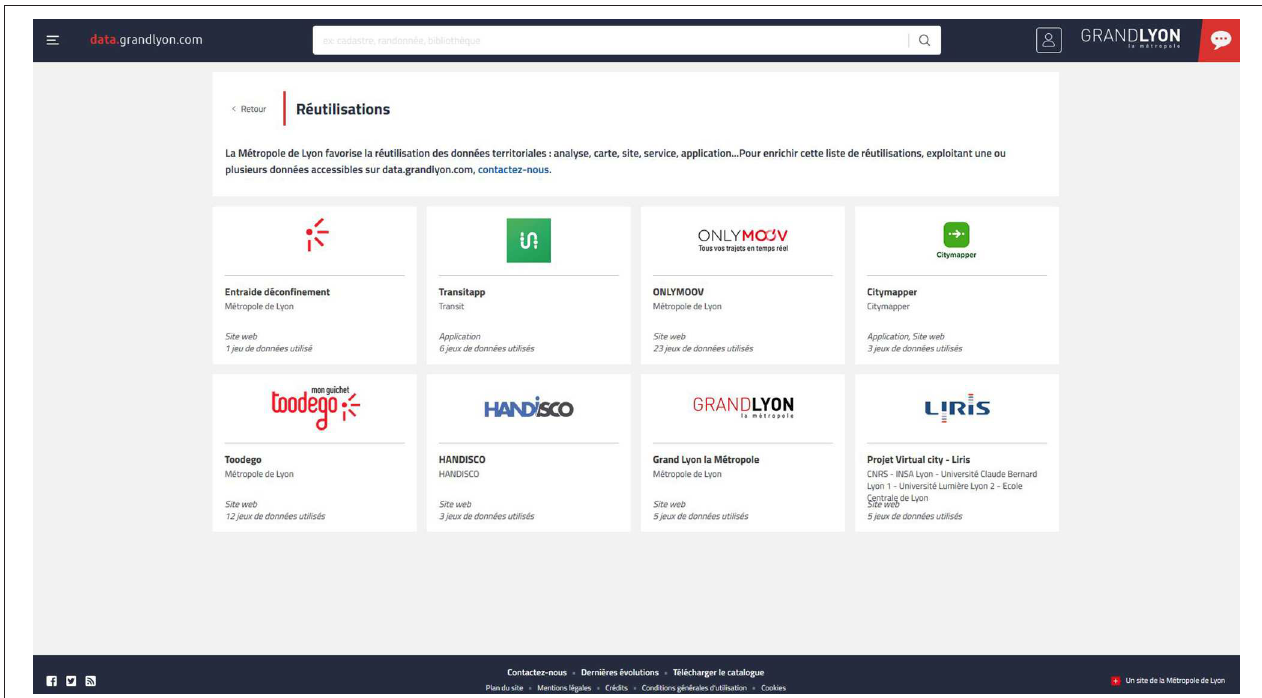
FIGURE 2 | A Screenshot of GrandLyon’s Open Data Portal depicting cases of data